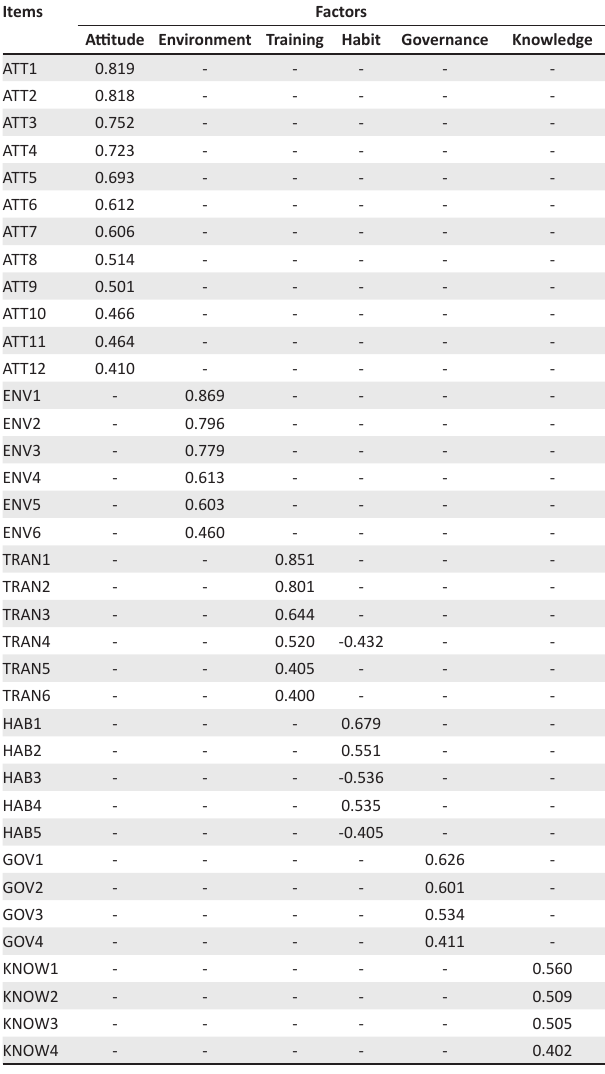
TABLE 3: Exploratory factor analysis results.